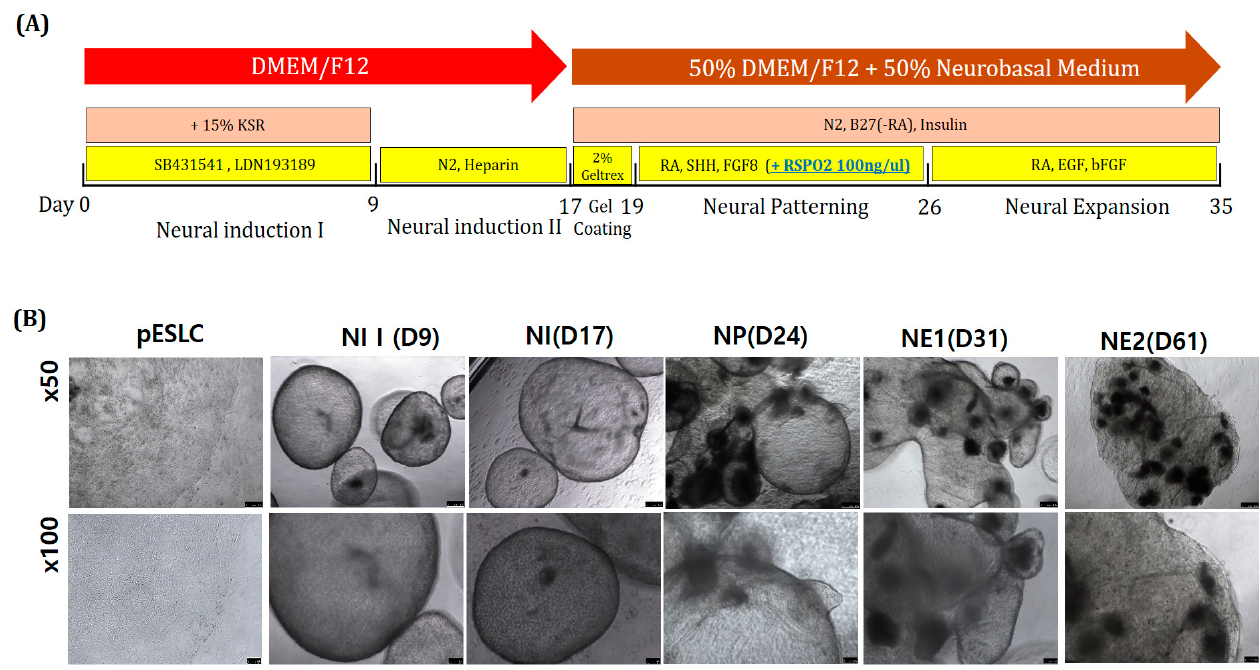
Figure 5. Progression of 3D neuro-organoid development from Yucatan EGFP pESLCs. ( A ) Schematic diagram of the 3D neuro-organoid method and timing. ( B ) Image of neuro-organoid according to differentiation stage. ×50: scale bar = 250 µm; ×100: scale bar = 100 µm.